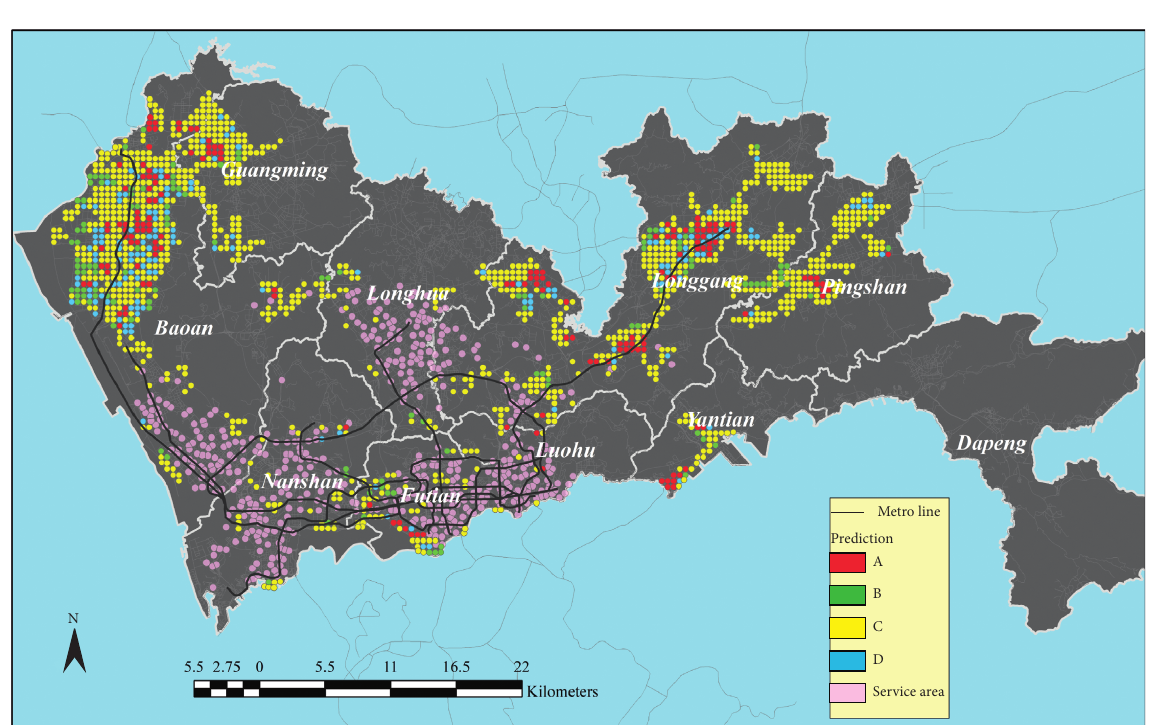
Figure 9: The predicted results of activity patterns in the new service